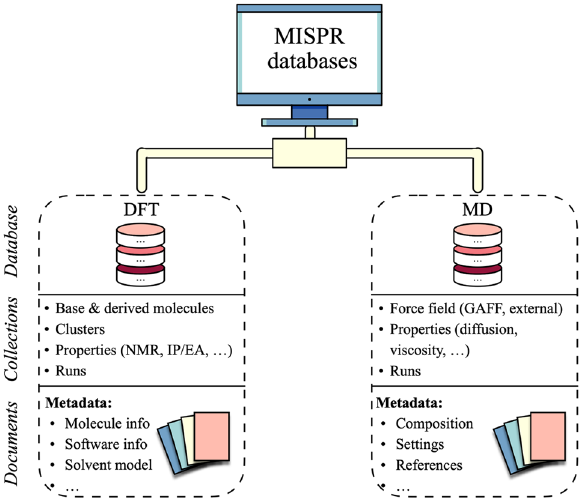
Figure 10. An overview of MISPR databases, including the collections in each database and the type of metadata stored in the documents of these